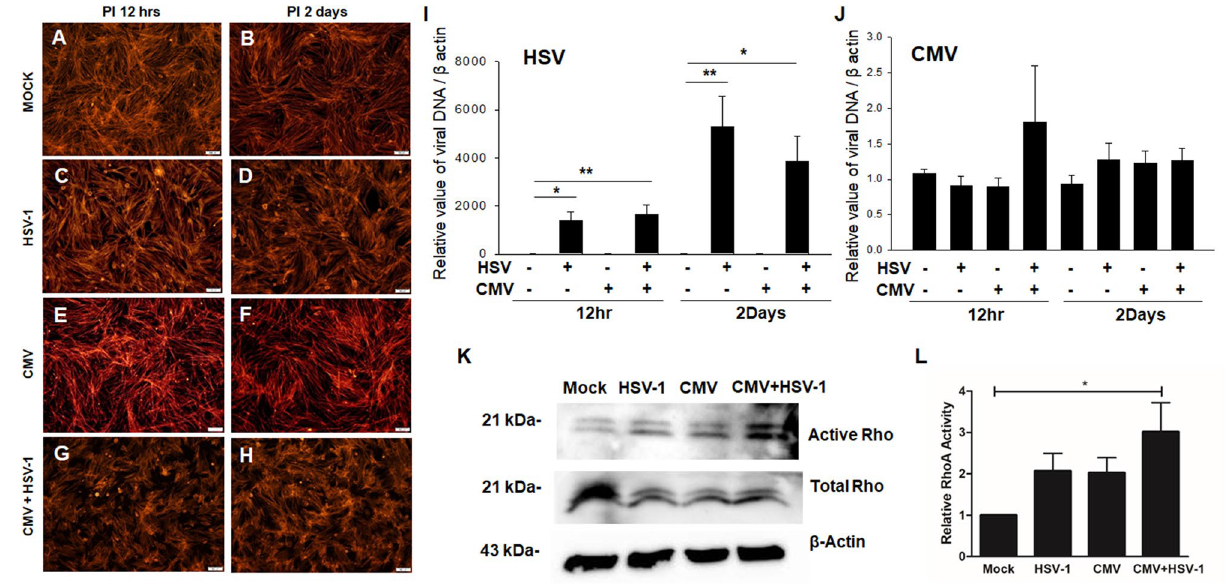
Figure 6. HSV-1 and CMV infection-induced changes in the human TM cell actin cytoskeletal organization, and accumulation of viral DNA at 12 h and 2 days post-infection. Primary TM cells obtained from ScienCell Research Labs were infected with HSV-1 or CMV alone, or with HSV-1 and CMV at a multiplicity of infection 1, and observed at 12 h ( A , C , E , G ) and 2 days post-infection (PI) ( B , D , F , H ). Stress fibers were stained with a Rhodamine Phalloidin (red signals) ( A – H ). Increased contraction of F-actin was observed after HSV-1 infection and CMV infection ( C – F ) when compared with mock infection ( A , B ). Moreover, the co-infection of HSV-1 and CMV also caused increase in F-actin formation ( G , H ). Cells were harvested and viral DNA was extracted from cells and processed for qPCR analysis of viral DNA accumulation using HSV-1 DNA polymerase and UL26 primer for HSV-1 ( I ) and CMV ( J ), respectively. Real-time PCR with β-actin primers were performed to serve as an internal control for input DNA. Data are the averages of three independent DNA samples from the infected cells. Activation of RhoA activity in TM cells at 2 days PI was significant after co-infection of CMV and HSV-1 in immunoblotting ( K ) and densitometric analyses ( L ). The immunoblot data were normalized to total Rho. Blots were cut prior to hybridization with antibodies. Data are shown as means ± SEM, N = 3. * P < 0.05 and ** P < 0.01 vs. transcripts from the mock infection within 12 h and 2 day PI using one way ANOVA with Dunnett’s multiple